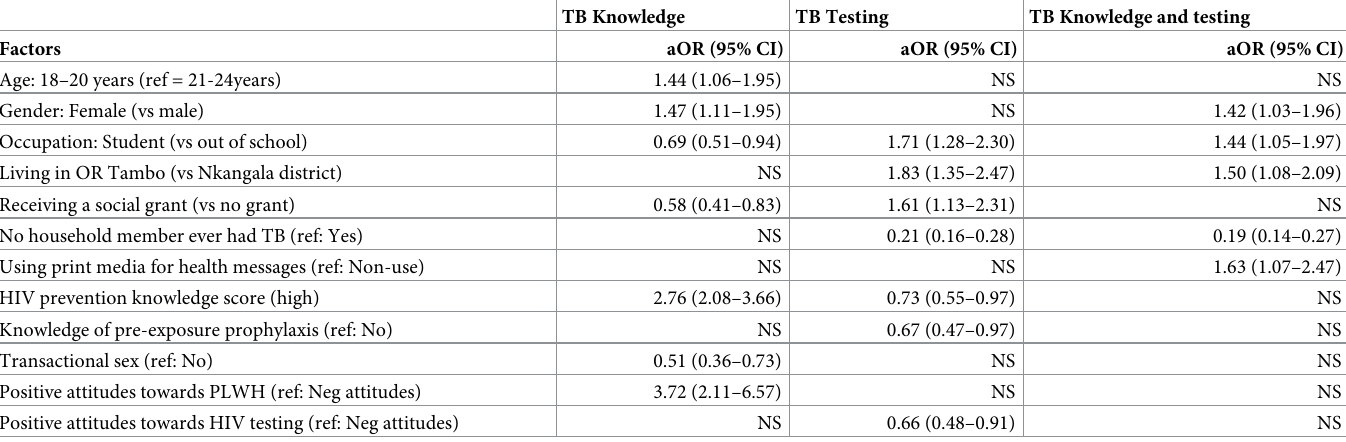
Table 3. Multivariate analysis showing factors associated with TB knowledge, TB testing and both TB knowledge and testing in Nkangala and OR Tambo districts. TB Knowledge TB Testing TB Knowledge and